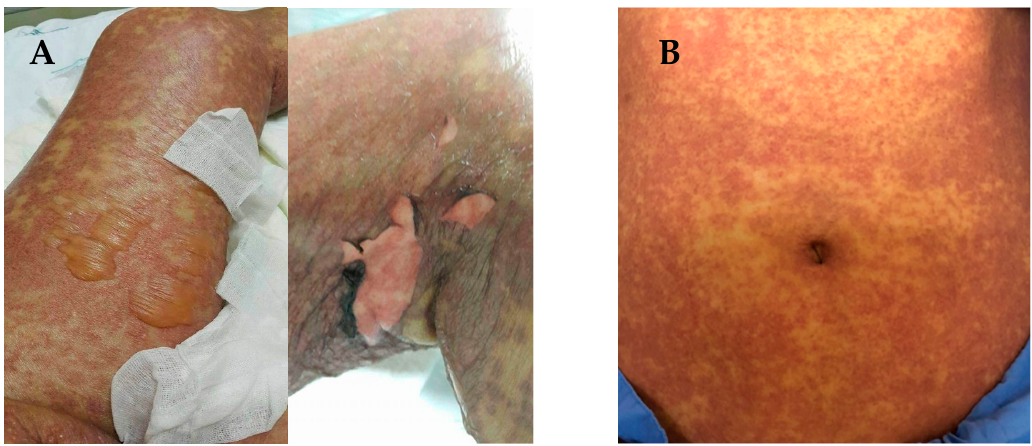
Figure 1. ( A ) Manifestations of Stevens-Johnson syndrome (SJS) and toxic epidermal necrolysis (TEN), in which the skin begins to blister and peel. Erythroderma, extensive skin lesions, aggressive detachment of the epidermis and erosion of mucous membranes can be observed; ( B ) dermatologic manifestations of drug reaction with eosinophilia and systemic symptoms (DRESS) typically consist of diffuse pruritic macular and urticarial rash. Facial oedema and periorbital areas with scale and crust around the nose and lip can be found. All patients have provided informed consent before being enrolled and provided the